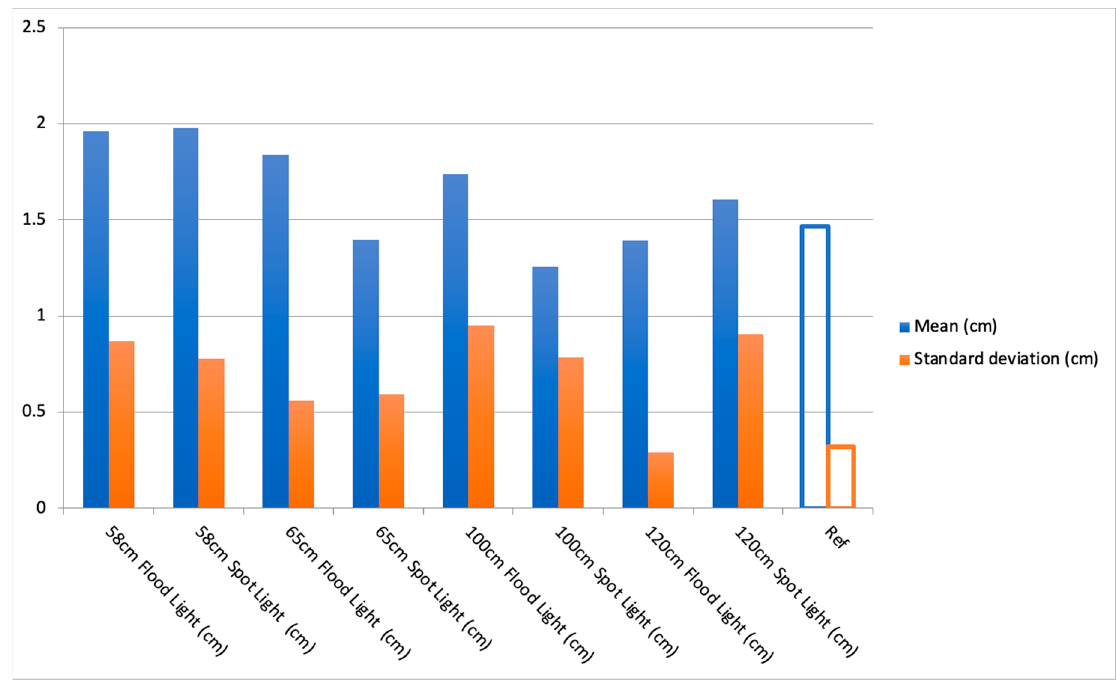
Figure 18. Mean and standard deviation of the distributions (reference and protocols).